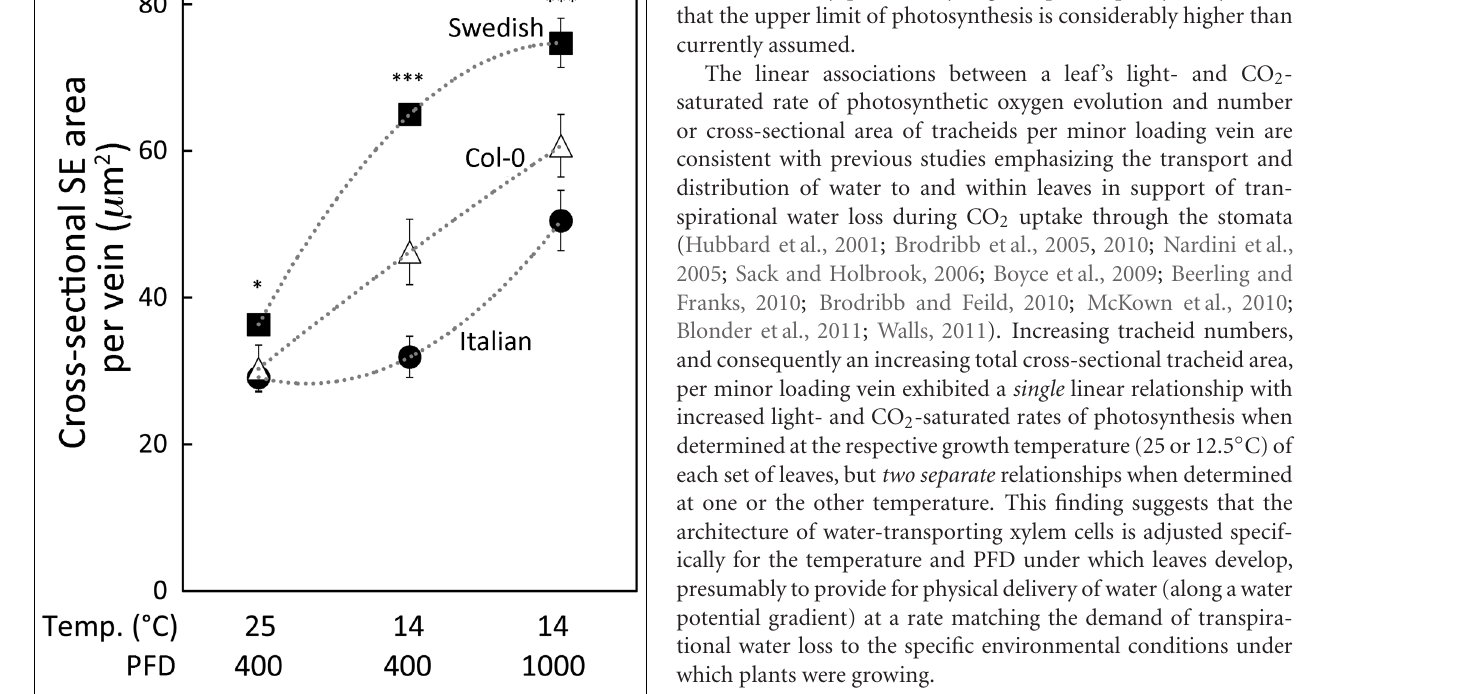
FIGURE 3 | Relationship between the cross-sectional area of sieve elements (SE) per minor loading vein and growth condition for three A. thaliana ecotypes (Italian ecotype, black circles; Col-0, white triangles; Swedish ecotype, black squares). Arabidopsis thaliana ecotypes were grown in controlled temperature (mean daytime leaf temperature indicated in ◦ C) and light (moderate PFD at 400, and high PFD at 1000 μ mol photons m − 2 s − 1 ) conditions. Actual daytime leaf temperatures varied between 24 and 26 ◦ C or between 12 and 16 ◦ C. Mean ± standard error of the mean shown ( n = 4 plants), and statistically significant differences between Swedish and Italian ecotypes for each growth condition indicated with an asterisk (* P < 0.05; *** P <